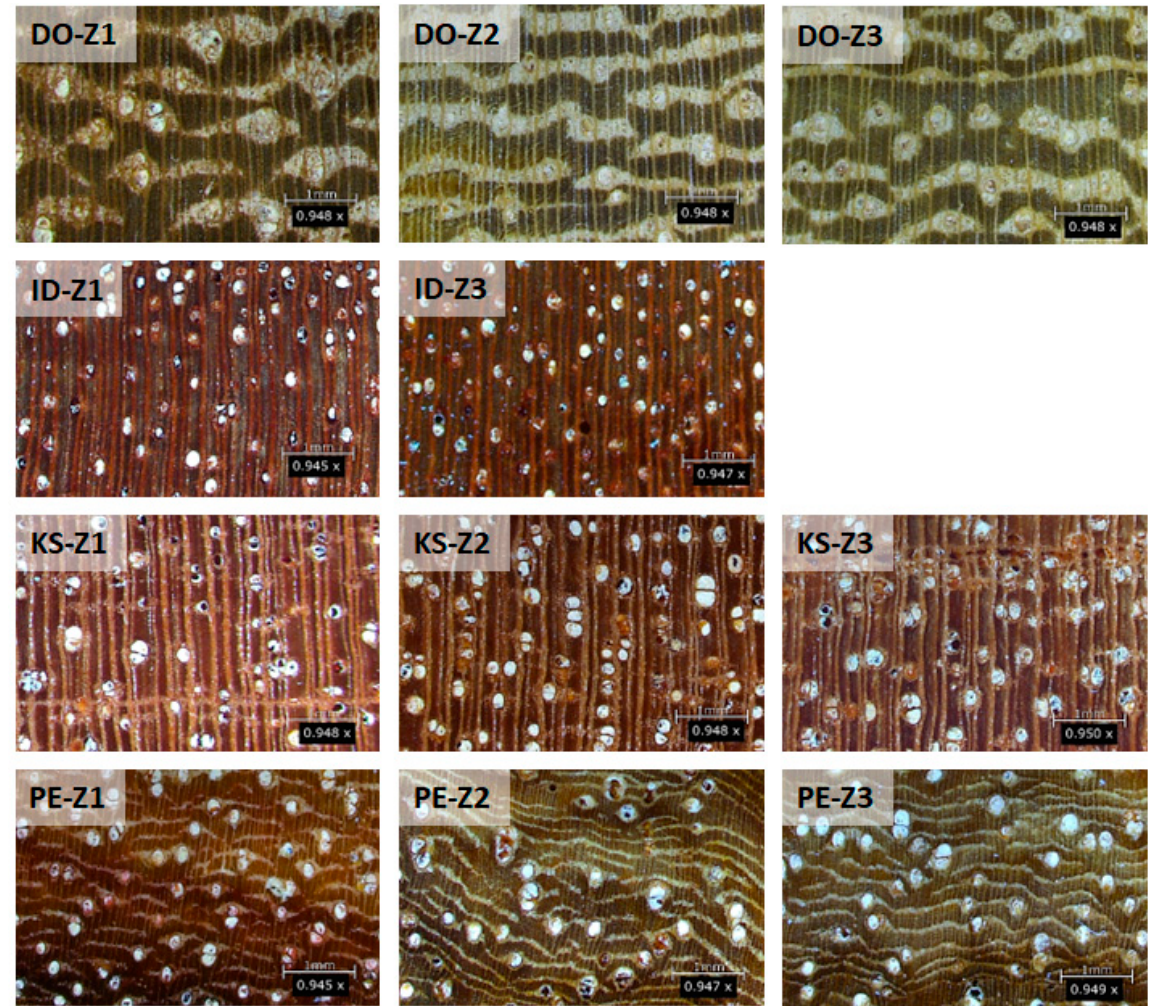
Figure 2. Transverse sections images of the studied wood. DO for Daniellia oliveri , ID for Isoberlinia doka , KS for Khaya senegalensis , and PE for Pterocarpus erinaceus . Z1, Z2, and Z3 refer to Kita, Sibi, and Kéniéba, respectively.